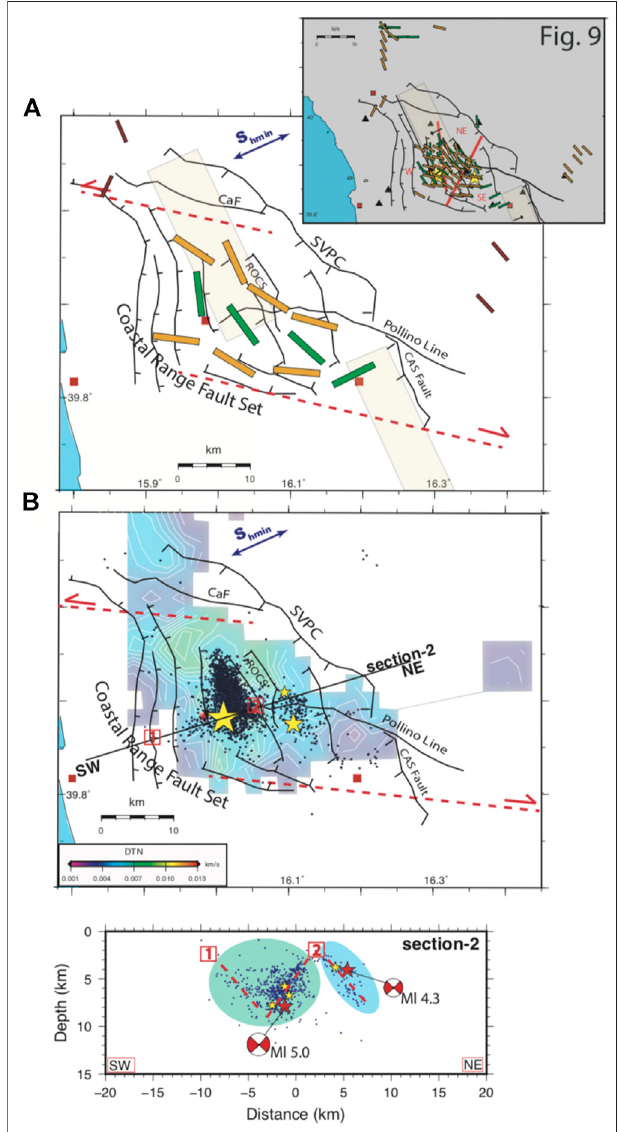
meanfastandnulldirections.Ingeneral,arotationfromroughlyWNW – ESEto NNW – SSE and WNW – ESE is observed. These orientations are related to major active faults, such as CaF, ROCS, and Pollino line, respectively, exceptfortheWestsectorwherefastandnulldirectionsarenotinagreement. (B) Map of interpolated values of δ tn and the superimposed 1D relocated seismicity. (C) Southerncross-sectionof1Daccuratelocation;greenandblue shadow are referred to as δ tn values, and dashed lines de fi ne the activated fault systems. In (B) – (C) , 1 and two represent the top points of the probable faultplanes projected in map. 1 falls into the CRFS area while two falls into the intersection between the ROCS area and the westernmost part of the Pollino line. In (A) – (B) , red dashed lines with arrows represent the regional scale strike-slipepisodesrelatedtogeodynamicprocesses, yellowstarsidentifythe strongest events, and the main fault systems are also